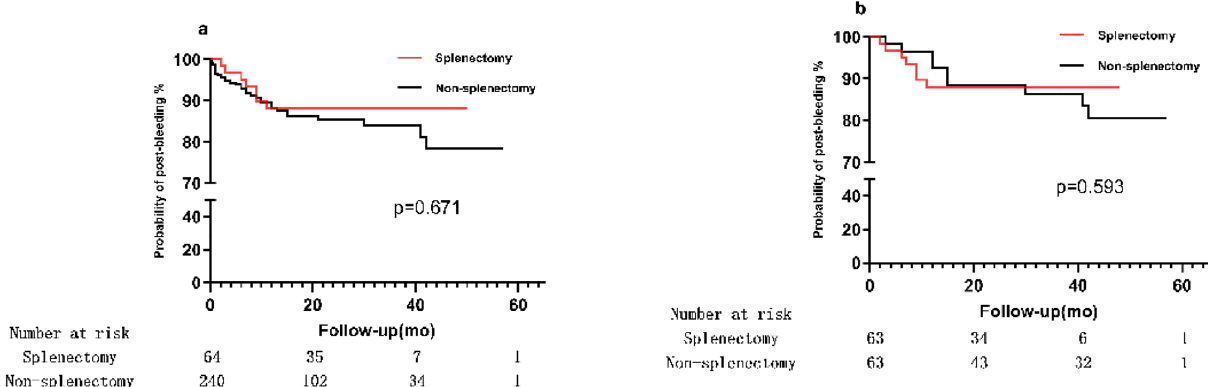
Figure 2. Kaplan–Meier survival curves of the splenectomy group and non-splenectomy group. ( a ) Post- bleeding Probability in the overall Cohort. ( b ) Post-bleeding Probability in the matched Cohort.